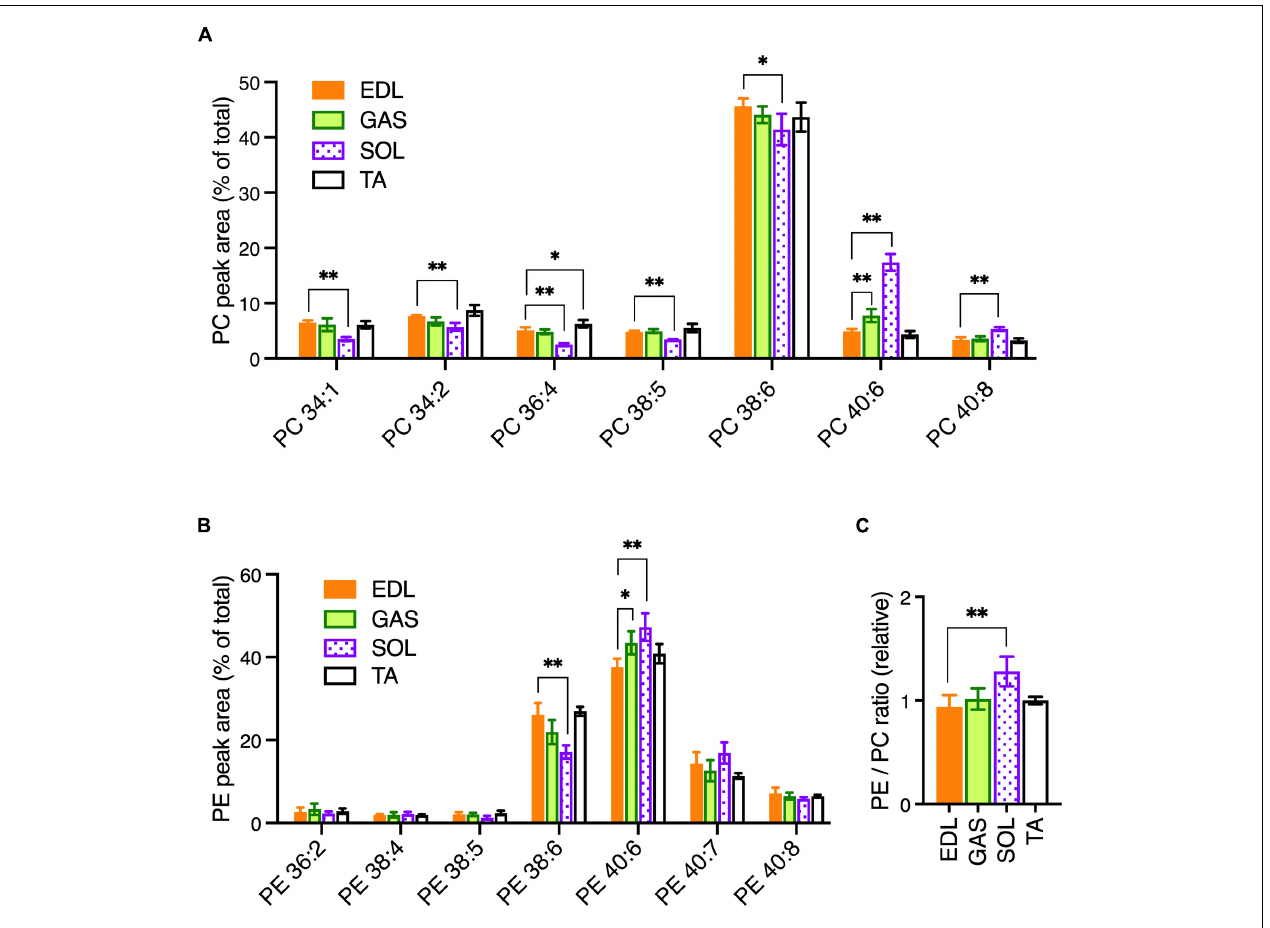
FIGURE 1 | PC and PE profiles in healthy EDL, GAS, SOL, and TA skeletal muscles of adult (15-week-old) C57BL/6 mice raised on CE-2 standard chow. PC (A) and PE (B) were measured by LC-MS/MS. EDL was selected as a standard muscle to determine the statistical variations. (C) Relative ratios of total detected amounts of PE to PC (ratio in EDL = 1). PC and PE peak values are expressed as the percentage of total PC or PE signals and means ± SD are plotted. The statistical significance of variations vs. EDL is based on Dunnett’s multiple comparison tests. ∗ p < 0.05, ∗∗ p < 0.01; n = 4